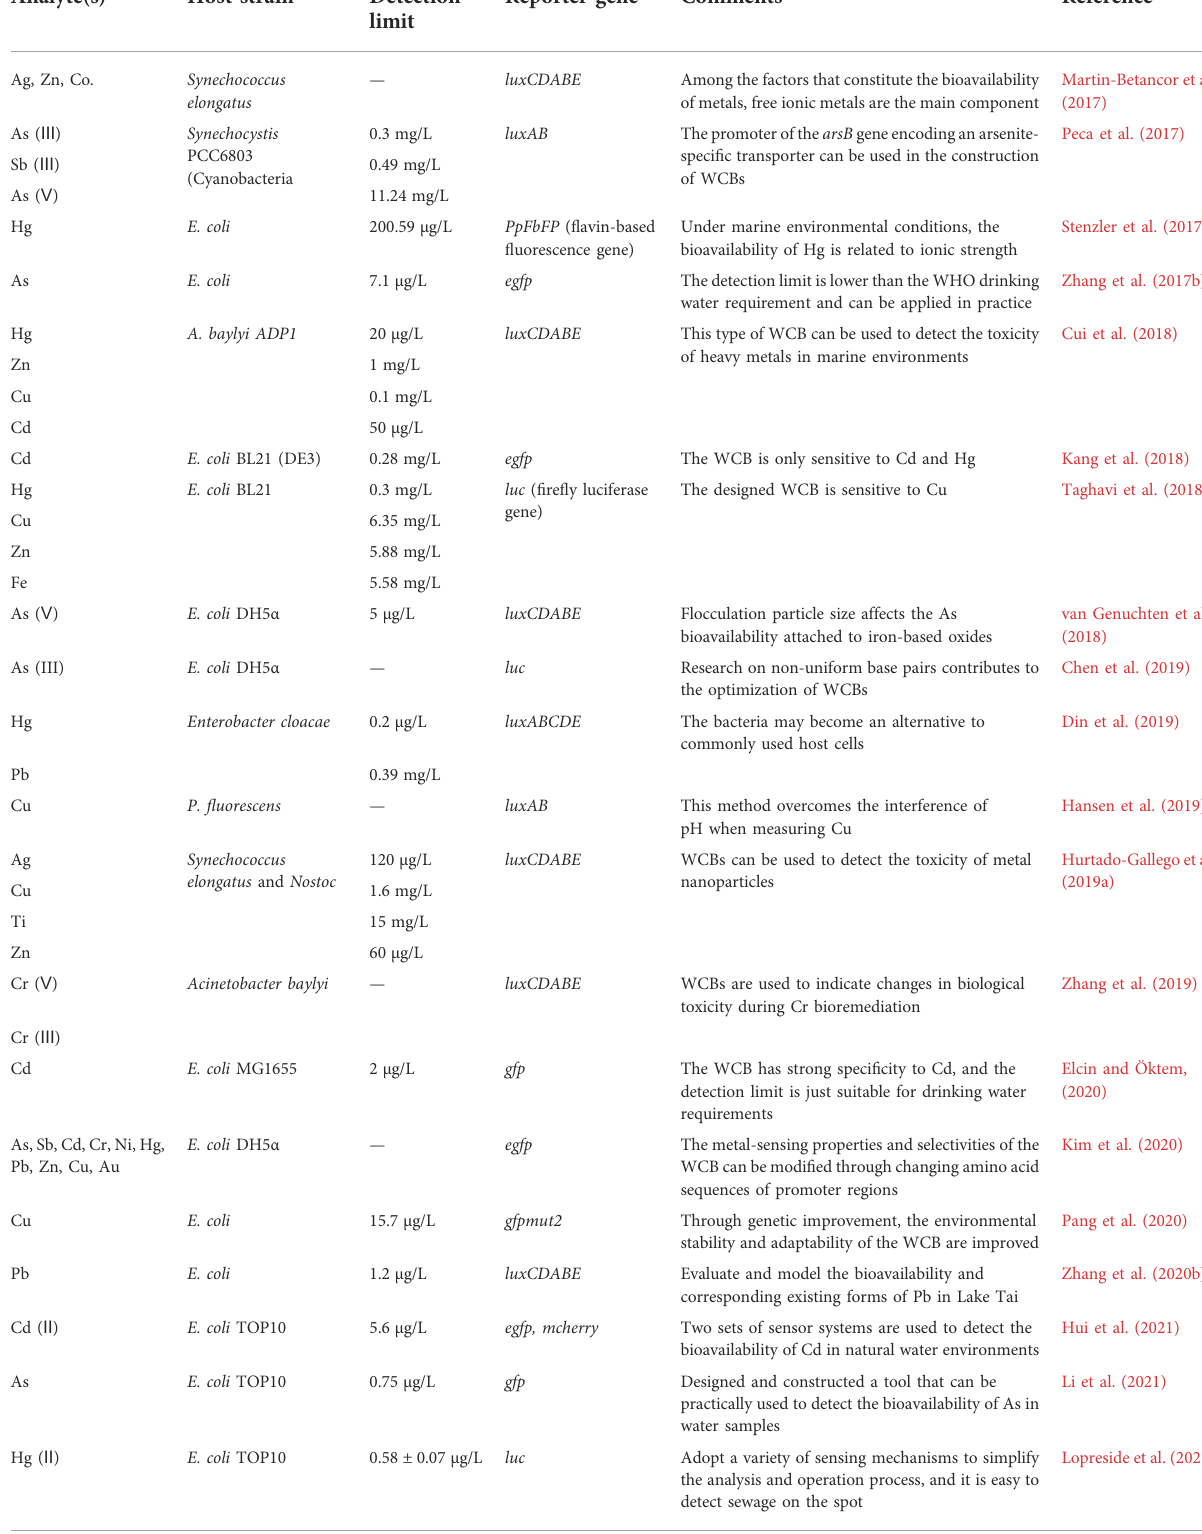
TABLE 2 Whole-cell bioreporter used for heavy metal detection in aquatic